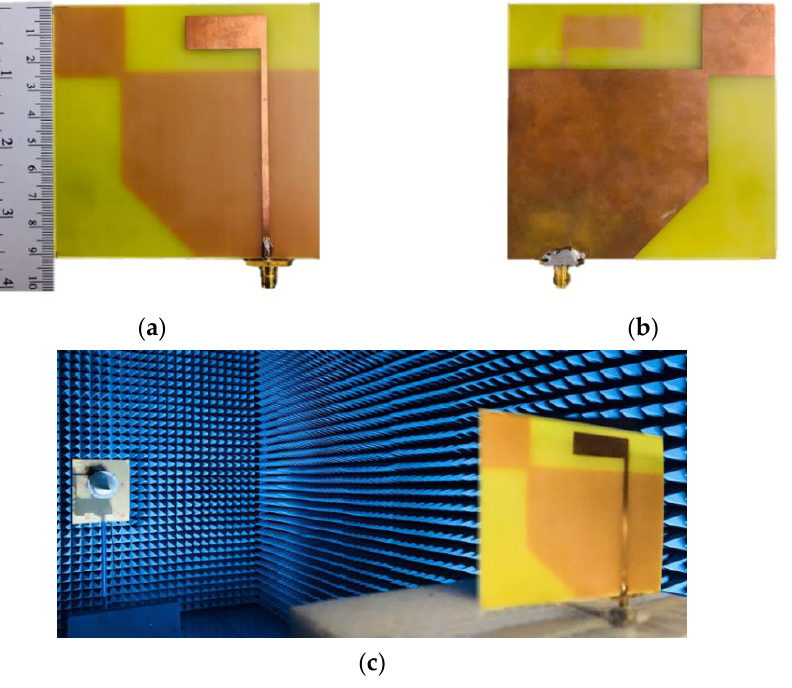
Figure 17. The prototype of the inverted L-shaped patch antenna with a corner-truncated partial ground plane diagonally adjoined with square branch: ( a ) front, ( b ) rear, ( c ) in anechoic chamber. Table 3. The extracted values for the relative permittivity of FR-4 (TLM140) at 1.5 GHz. Measurements 1st Extracted